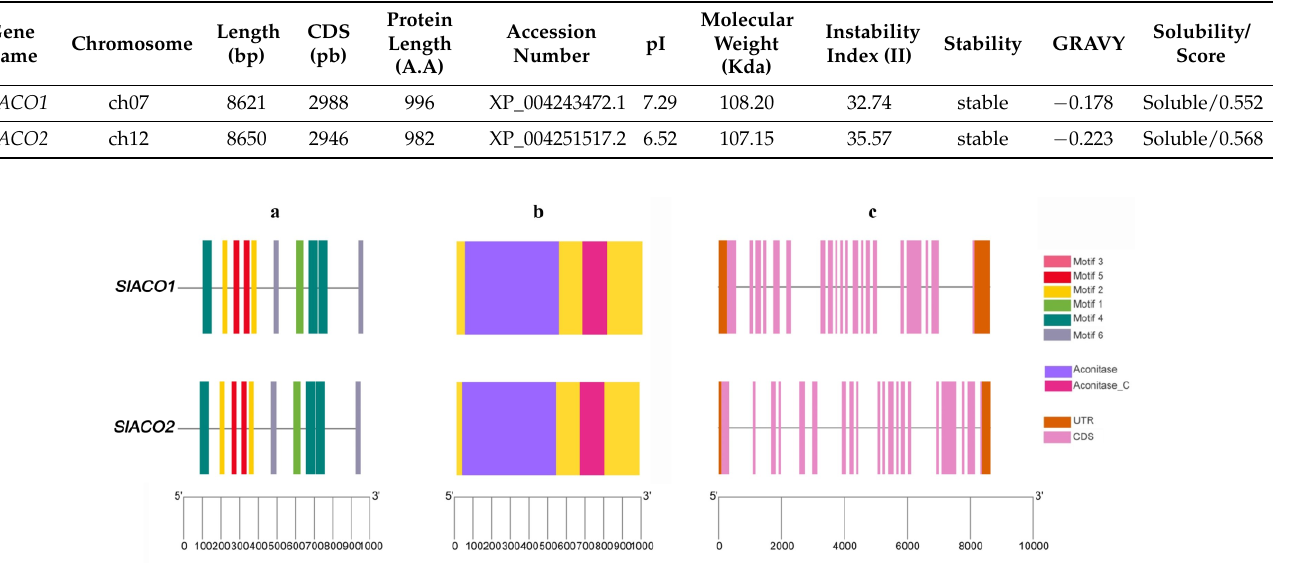
Figure 1. Motif structure, conserved domains, and exon-intron architecture of SlACO genes. ( a ) Structure of 6 conserved motifs analyzed through MEME suite tool online. Legends indicate the color of each motif. ( b ) Conserved domain structure of SlACO genes in tomato. Two conserved domains were found and presented in purple and dark pink colors. ( c ) Exon-intron architecture of SlACO genes. The light pink boxes indicate exons, the solid line indicates introns, and the brown boxes indicate the non-coding untranslated regions.